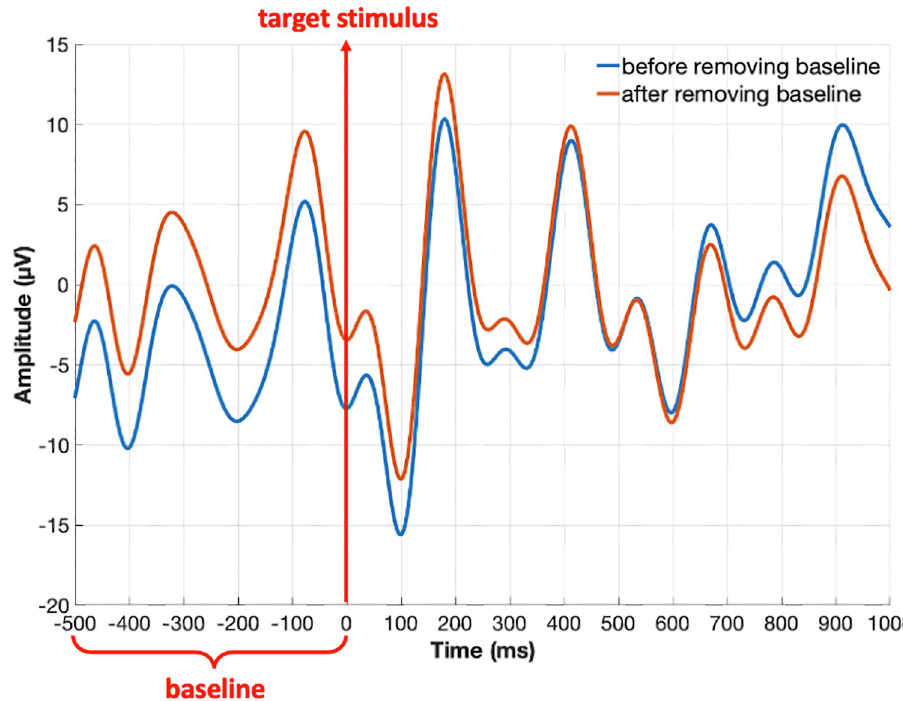
Fig 8. Data after and before baseline noise